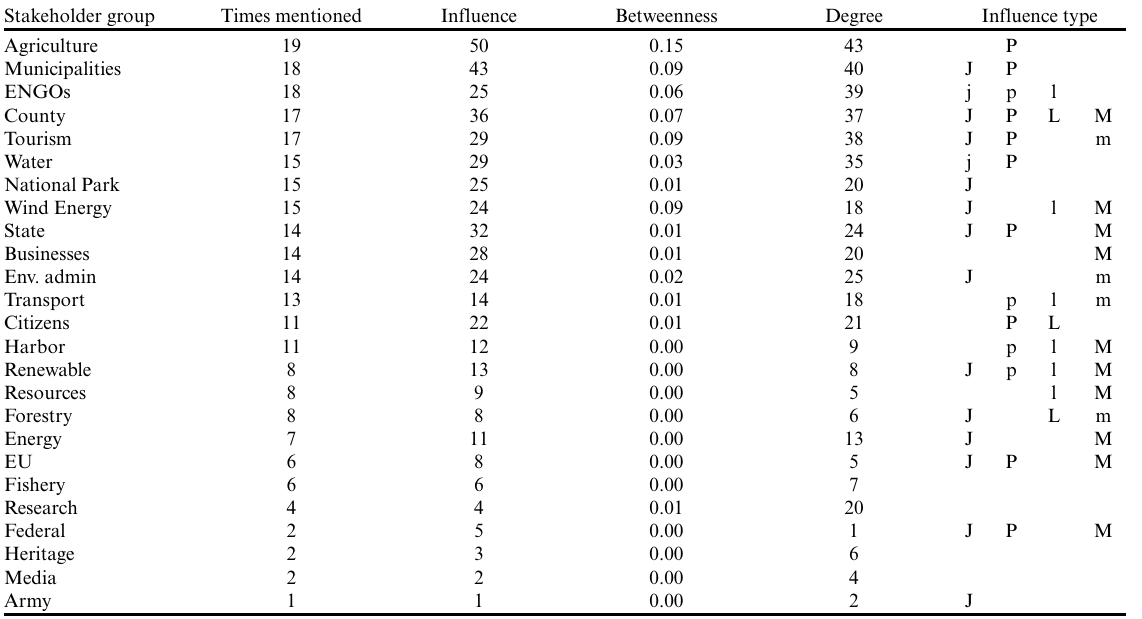
Table 1. The 25 stakeholder groups and their times mentioned, their aggregated influence, their betweenness and degree centrality values, and the type of influence they hold. The table is organized according to “times mentioned.” Label abbreviations: Water – water boards including drinking water, drainage, and flood control; Env. admin –